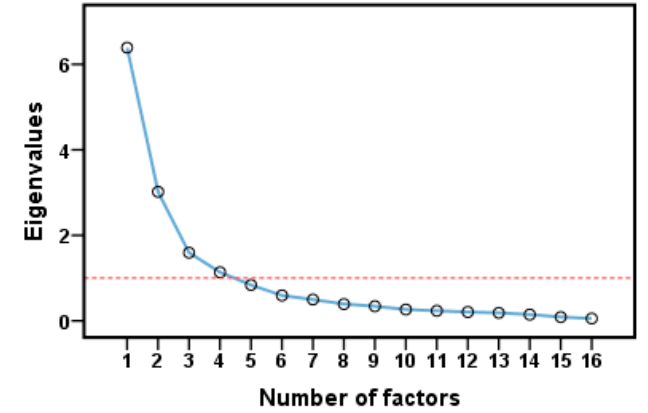
Figure 7. Scree plot of the factor analysis (after varimax rotation). Table 3. Loadings of factor analysis carried out with all 16 analyzed elements (after varimax rotation).